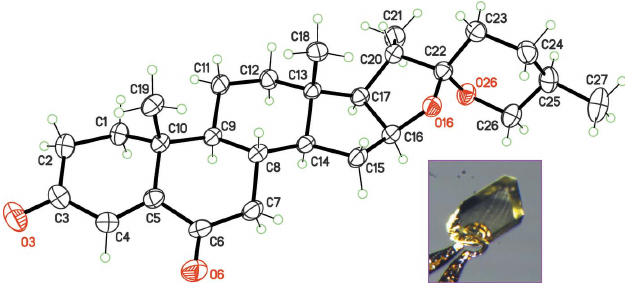
Figure 1 Molecular structure of the title steroid, with displacement ellipsoids for non-H atoms at the 30% probability level. The inset is the crystal used for data collection. The largest dimension is 0.5